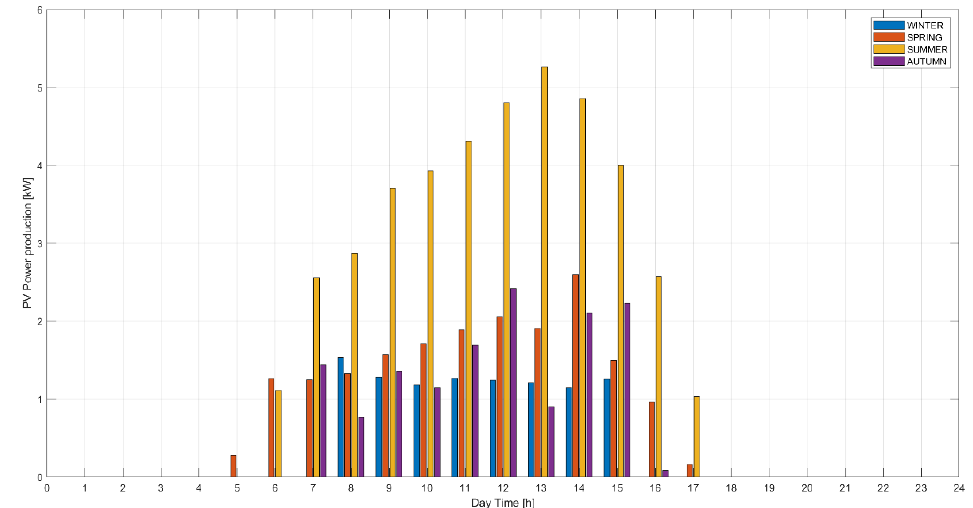
Figure 6. Estimation of power that can be produced by a residential PV system during a typical day in different seasons.